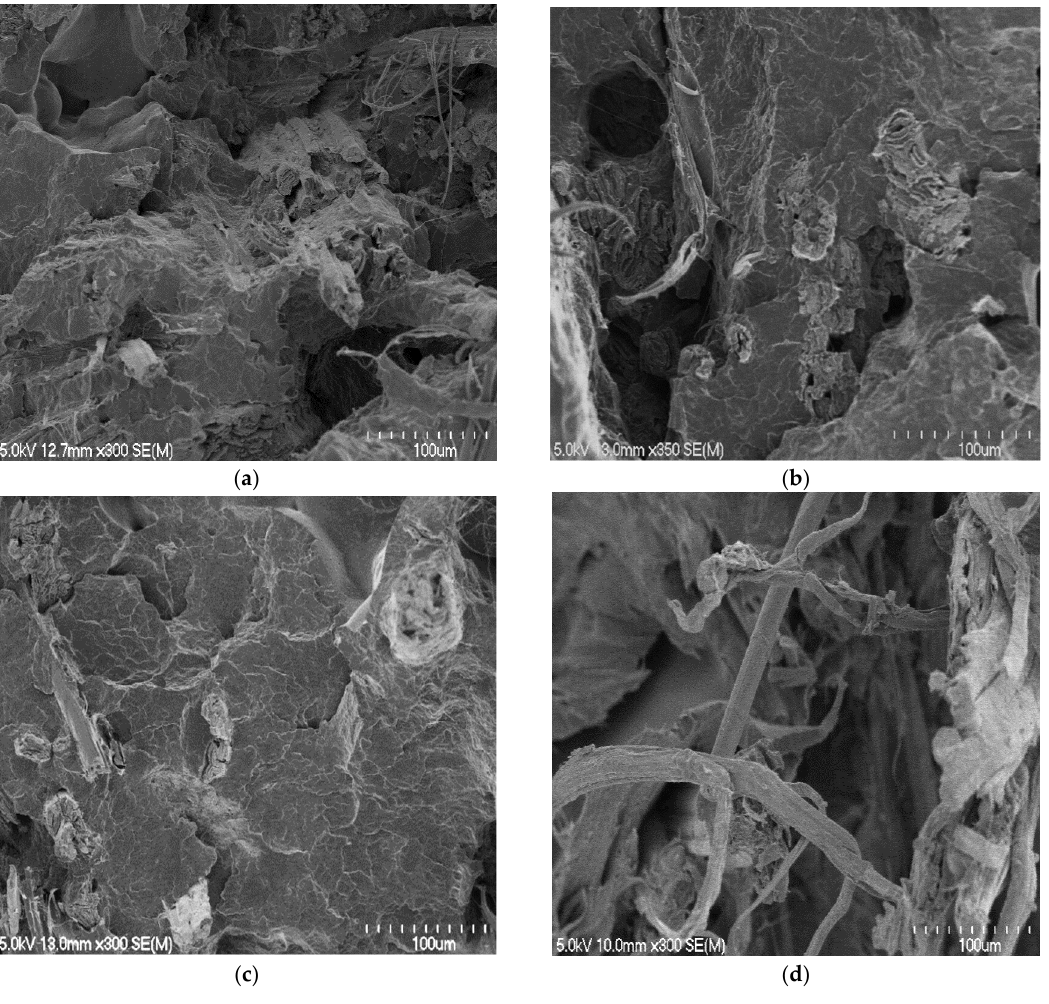
Figure 7. Sample scanning electron micrographs of tensile fracture surfaces of composites containing approximately 30 wt% fibre contents made with polymer sheets of: ( a ) 0.66, ( b ) 0.56, ( c ) 0.29, and ( d ) 0.24 mm.